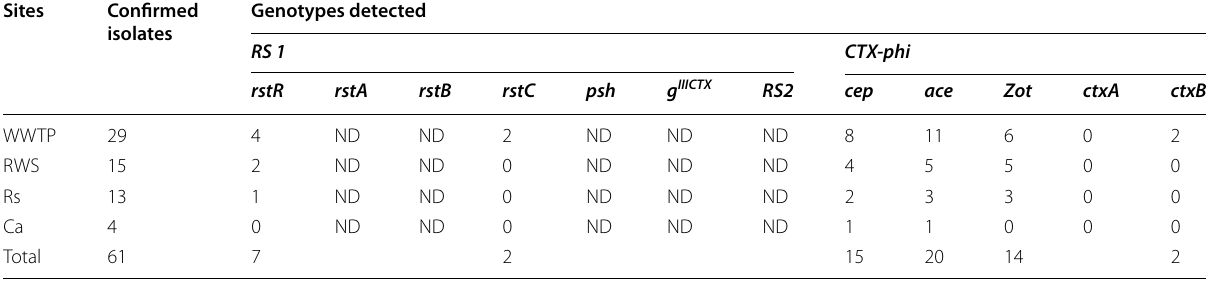
Table 3 Number of confirmed/genotypes detected for atypical V. cholerae and other members